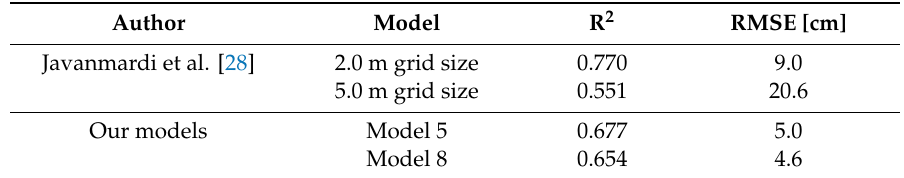
Table 10. Comparison with other